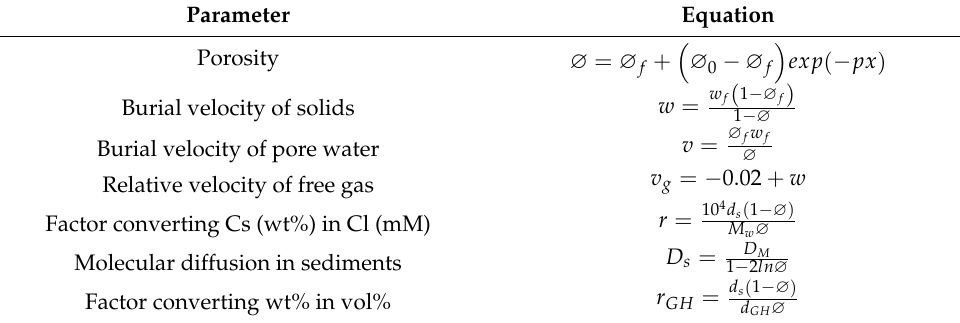
Table A1. Depth-dependent parameters.